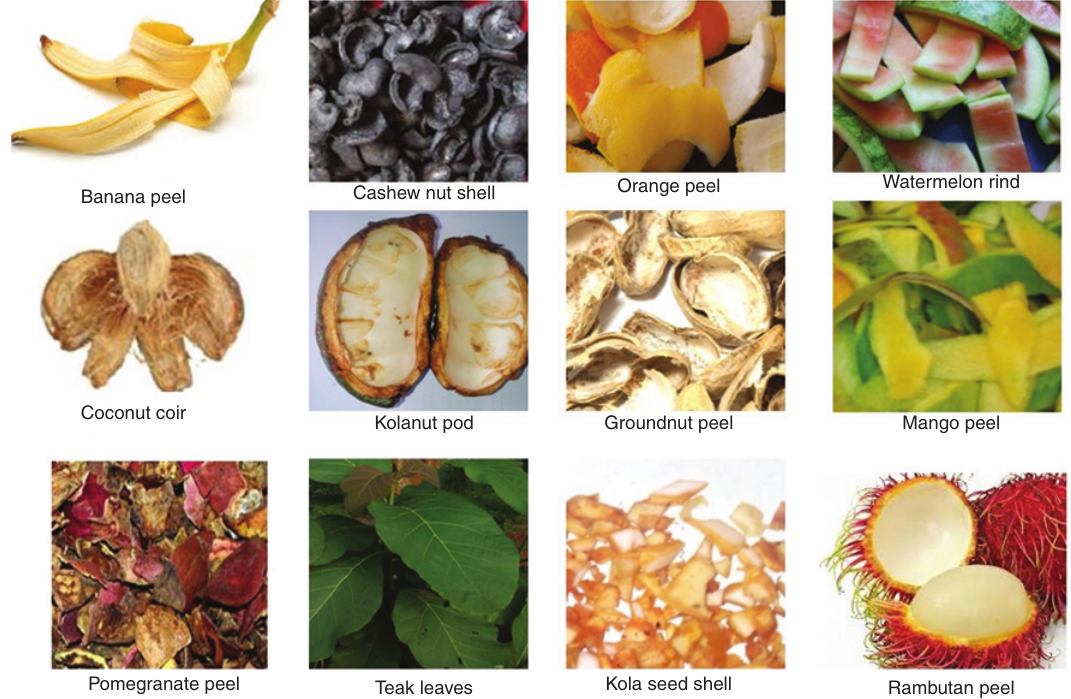
Figure 1: Some agro-wastes used for the biogenic synthesis of nanoparticles.